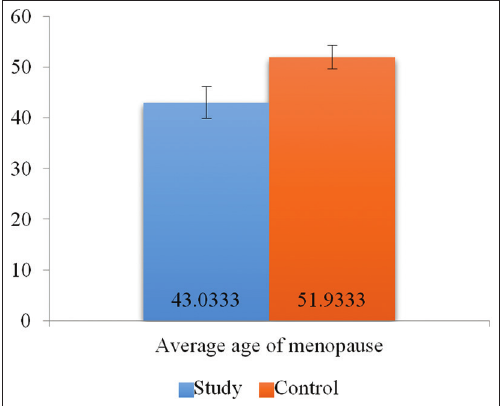
FIGURE 2. The average age of menopause.